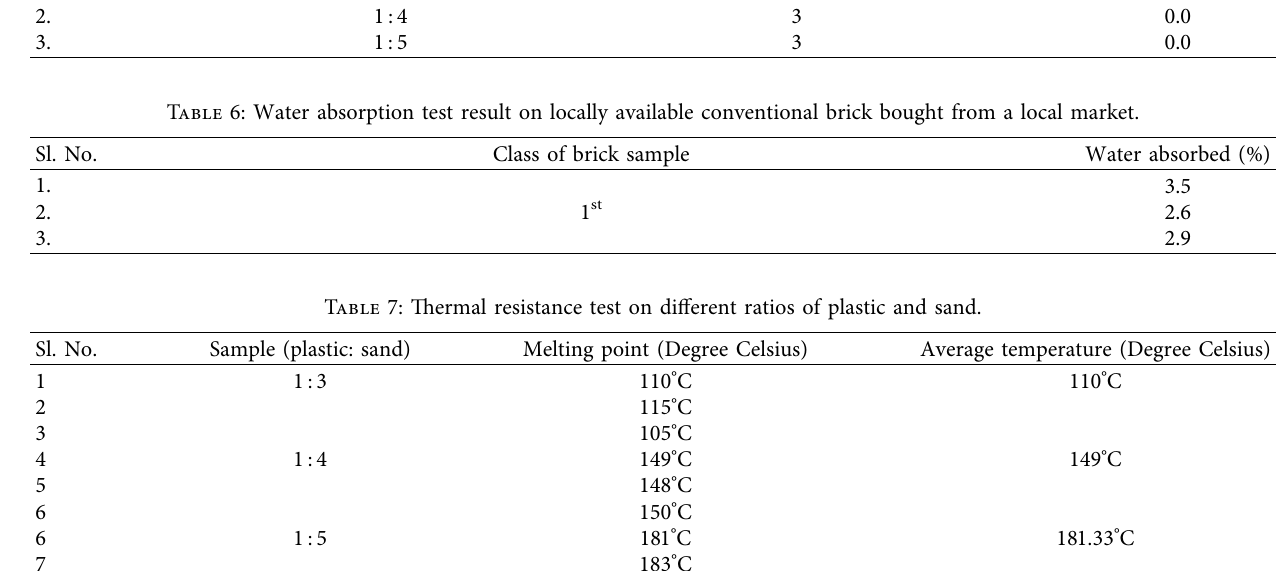
Table 5: Water absorption test result on the different ratios of plastic and sand. Sl. No.